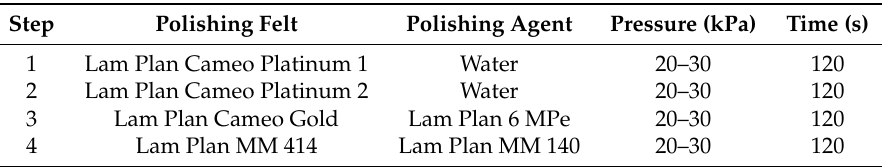
Table 1. Grinding sequence for petrographic